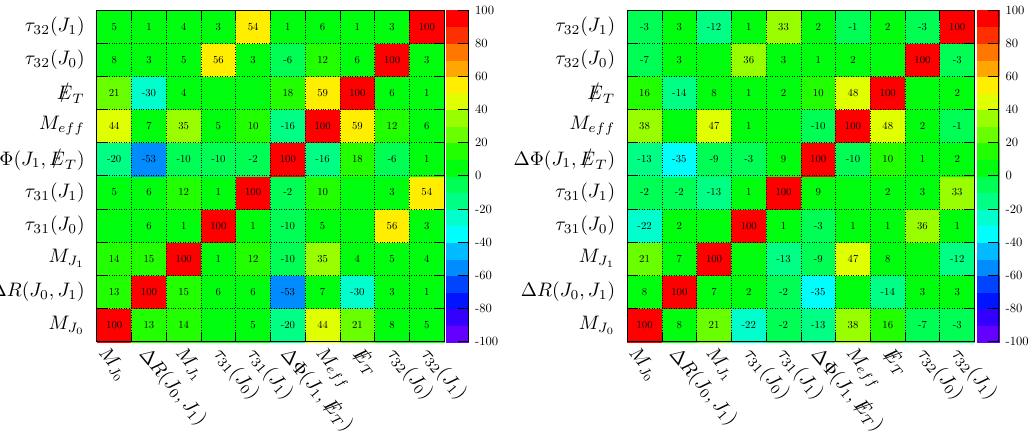
Figure 8. Linear correlation coefficients (in percentage) between different kinematical variables for the signal (BP3, left panel) and background (right panel). Missing entries correspond to a negligible correlation smaller than one. Positive and negative coefficients indicate that two variables are correlated or anti-correlated,